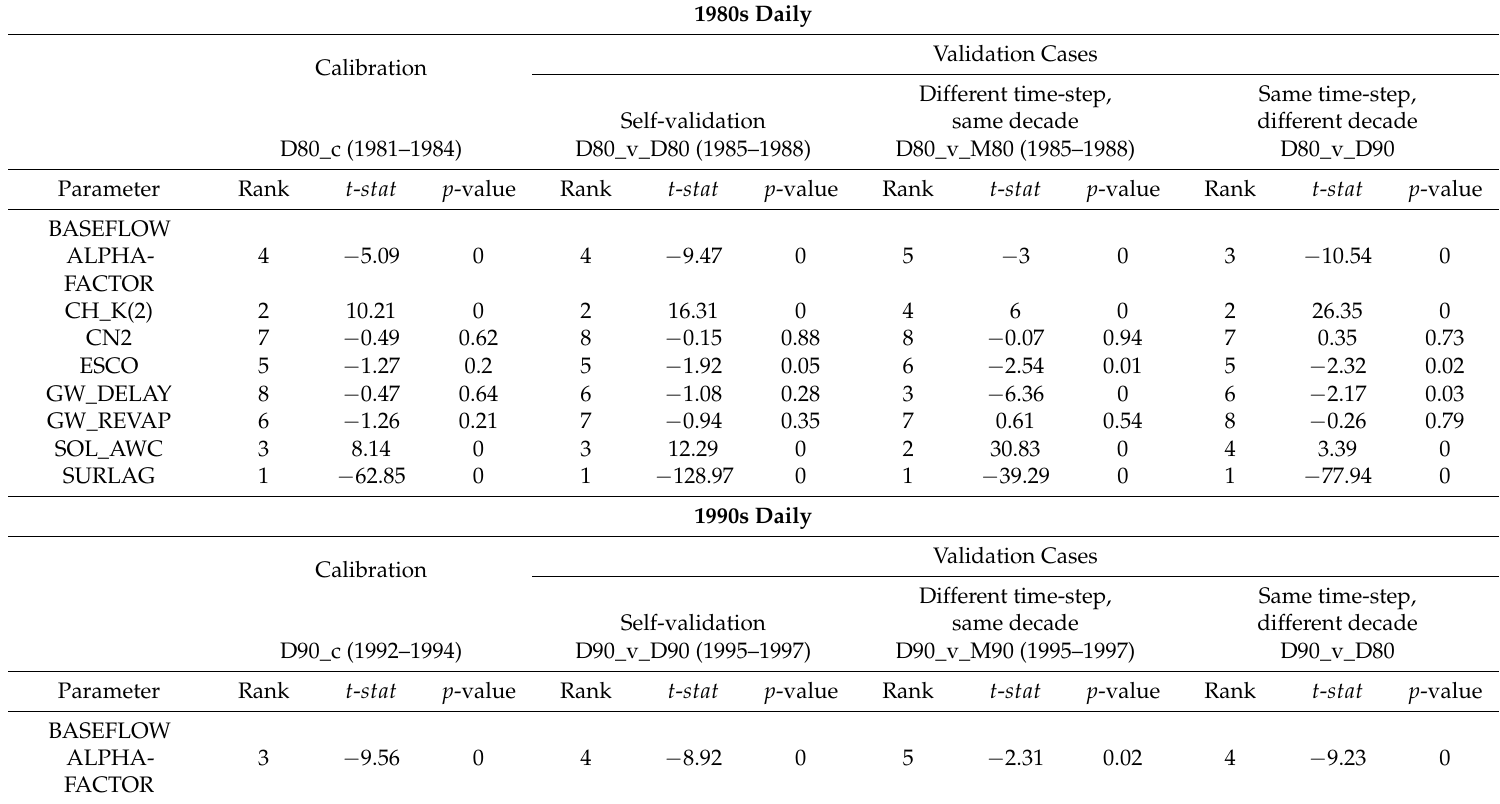
Table A1. Results of global sensitivity analysis for parameters corresponding to 1980s daily, 1990s daily, 1980s monthly, and 1990s monthly calibration and validation cases (based on Table 3 and Section 2.4.3). The parameter rank, t -statistic ( t - stat ) value, and a p -value are indicated for each case. The sensitivities are estimates of the change in the objective function due to changes in each parameter (based on a linear approximation), while all other parameters are changing [47]. A larger absolute value of the t -statistic ( t - stat ) and a lower p -value occur for parameters that are significantly different from 0, subsequently resulting in the relative parameter ranking (a lower numerical rank value is more